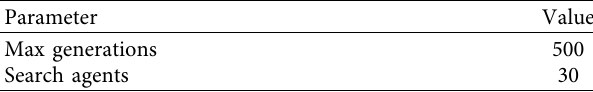
Table 3: Different variables in the GWO algorithm.